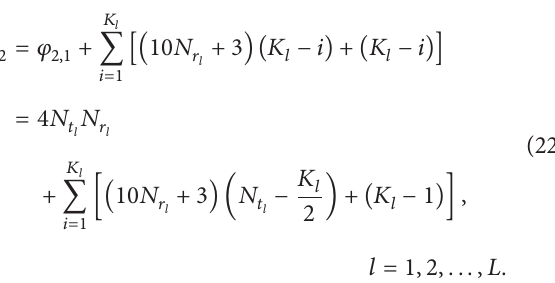
Figure 2: BER performance of different TAS schemes in SM-MIMO with 𝑁 𝑡 = 50 , 𝑁 𝑟 = 2 , and 𝑁 𝑠 = 32 .